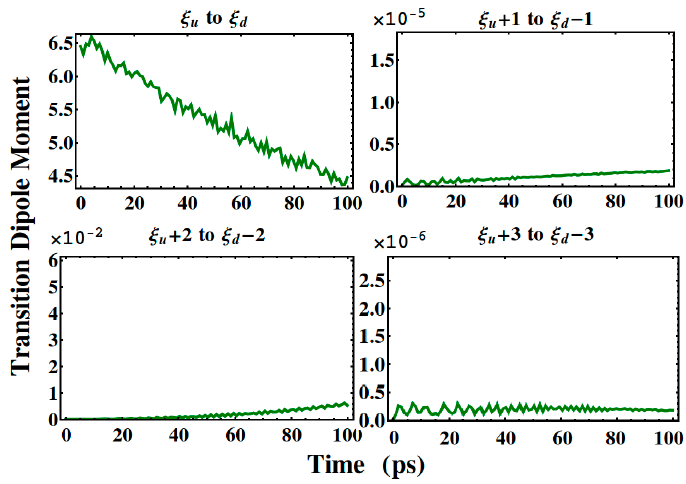
Figure 5. Time evolution of the square of selected sub-dipole moments between different eigenstates (the units of the vertical axis are e 2 Å 2 ).